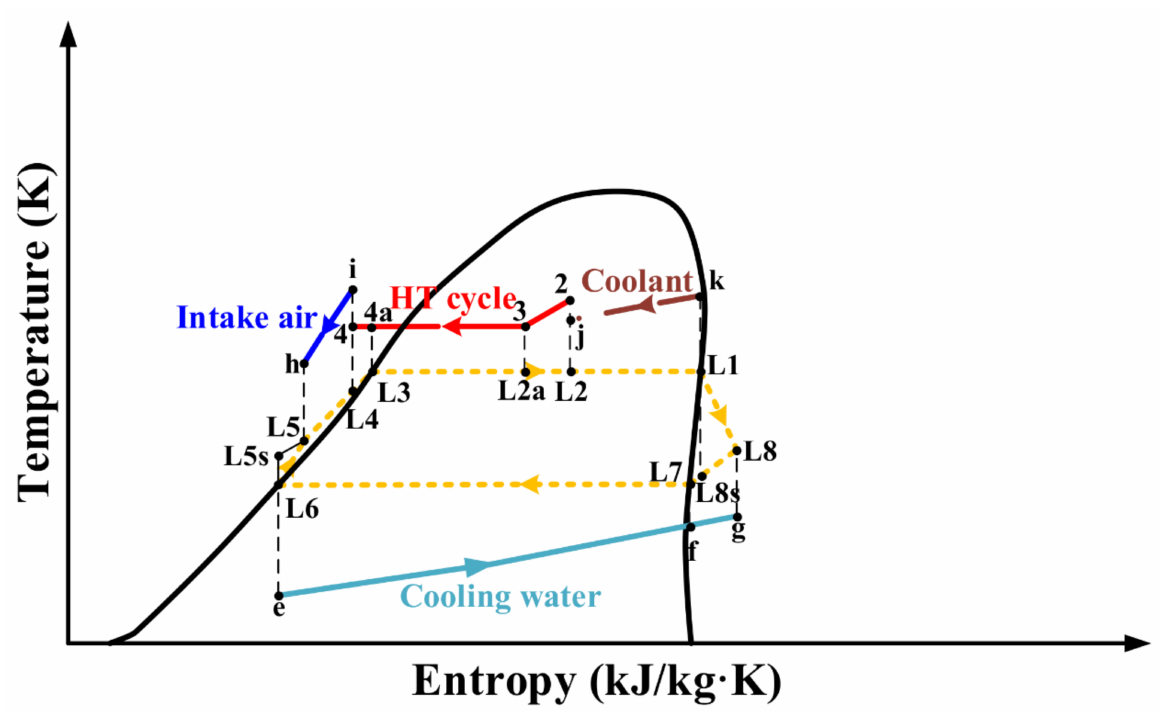
Figure 6. LT loop of the DORC